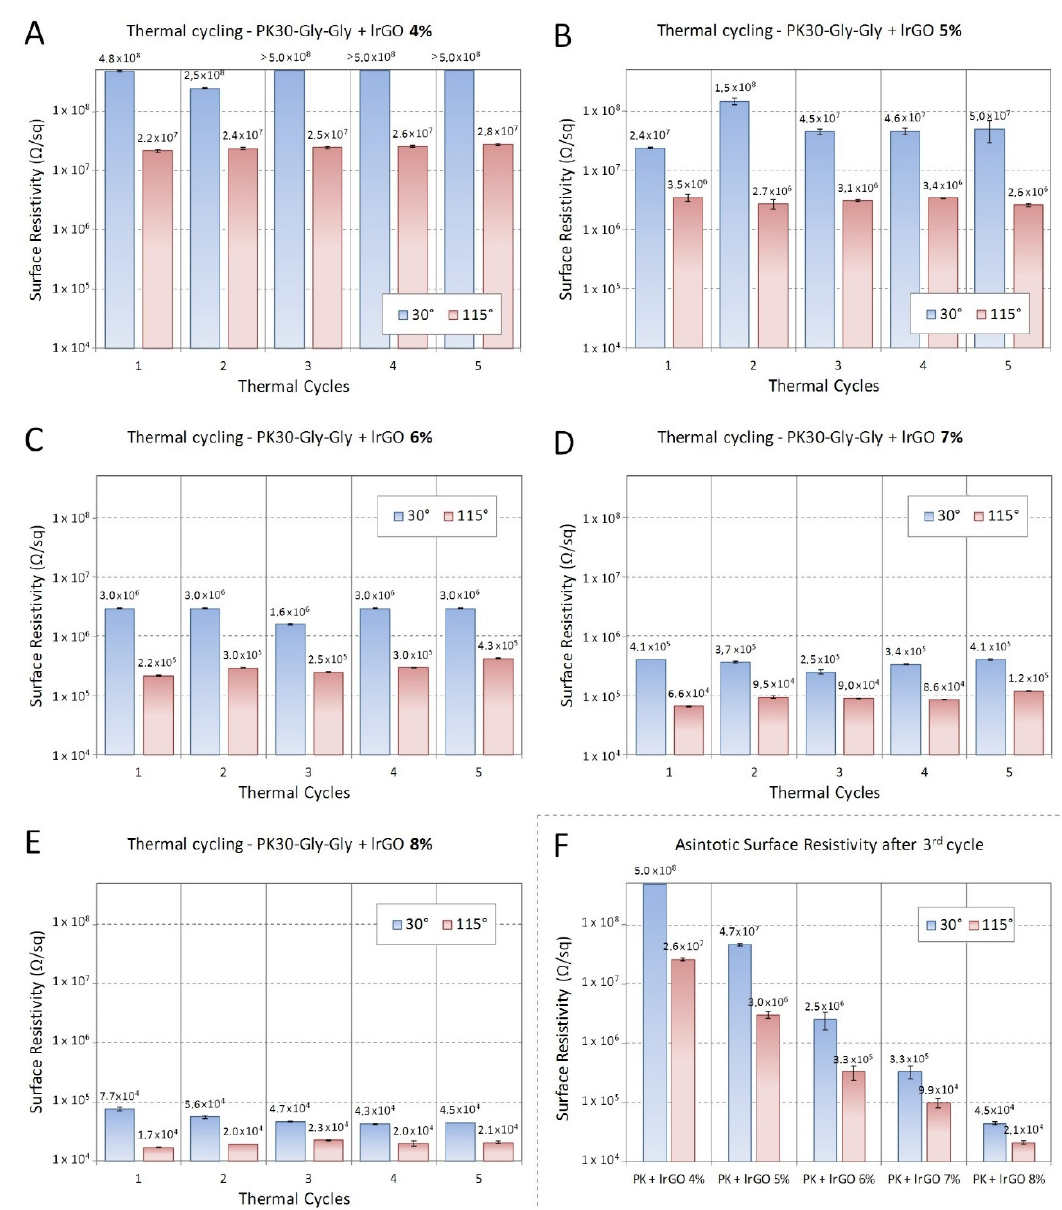
Figure 9. Surface resistivity measured at 30 °C (light blue) and 115 °C (light red) upon repeated cycles of the nanocomposite composed by PK30-Gly-Gly and lrGO. ( A ) 4 wt. %, ( B ) 5 wt. %, ( C ) 6 wt. %, ( D ) 7 wt. %, and ( E ) 8 wt. %. Sample thickness of 1.05 mm. ( F ) Asymptotic surface resistivity as average over last three thermal cycles.